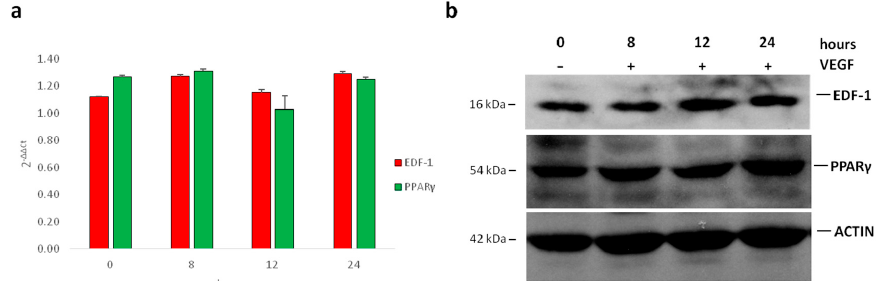
Figure 1. The total amounts of endothelial differentiation-related factor 1 (EDF1) and peroxisome proliferator-activated receptor gamma (PPAR γ ) in cells treated with VEGF. Human umbilical vein endothelial cells (HUVEC) were treated with 50 ng/mL of vascular endothelial growth factor (VEGF) for 0, 8, 12, and 24 h. ( a ) Real-Time PCR was performed on RNA samples. Two different experiments in triplicate were performed; ( b ) cell lysates were analyzed by western blot using antibodies against EDF1, PPAR γ , and actin. A representative blot is shown.